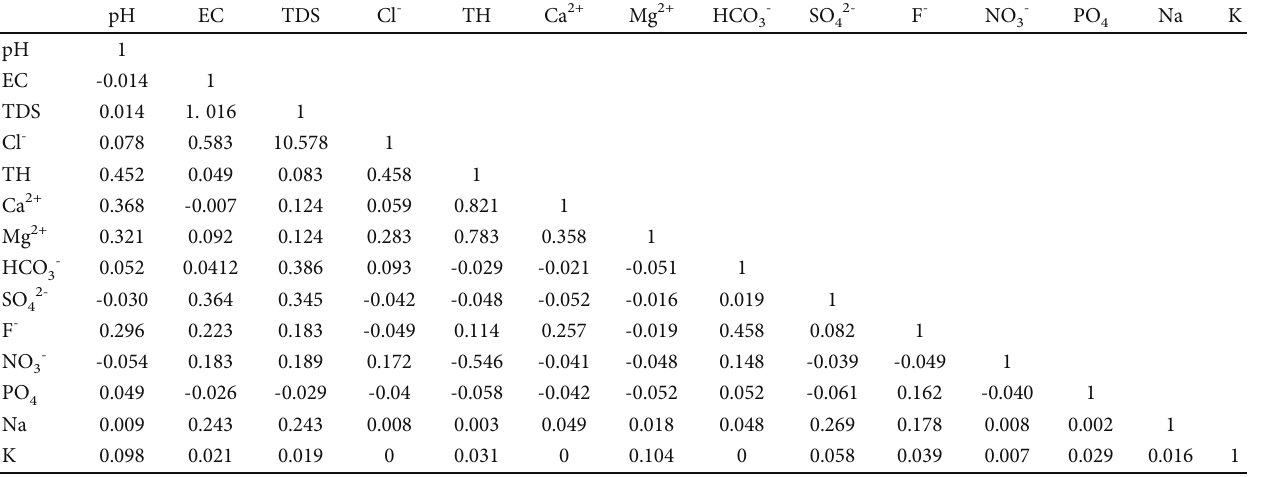
Table 2: The coe ffi cients of correlation ( r ) between several water quality metric premonsoon.